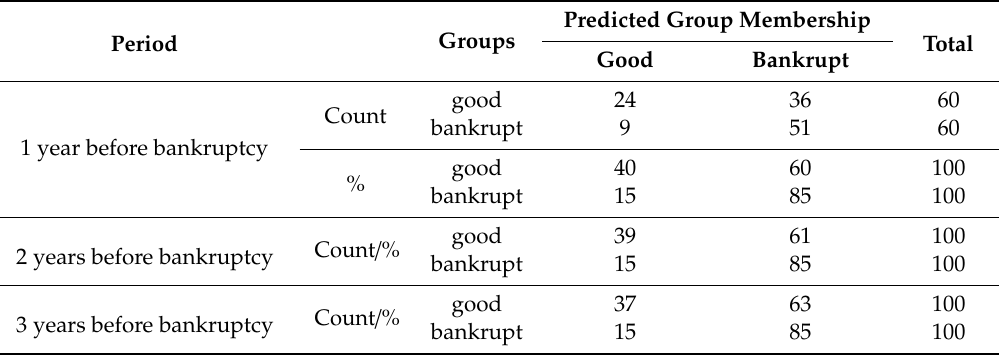
Table 8. Classification results from decision trees.